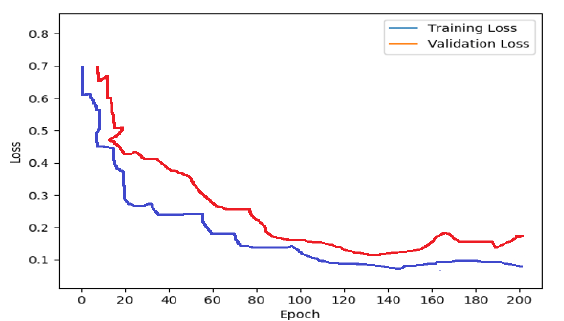
Figure 11. Training and Validation loss (Alexnet).